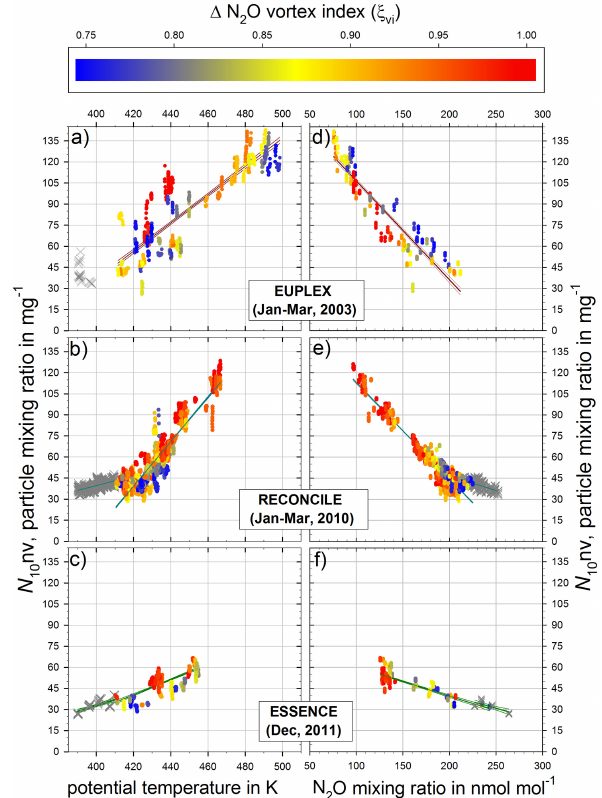
Figure 7. Mixing ratio of non-volatile particles N 10 nv as a function of potential temperature (cid:50) ( a to c ) and as a function of N 2 O mixing ratio ( d to f ) for measurements inside the vortex (i.e., where (cid:49) N 2 O vortex index ξ vi > 0.75). Data points are color-coded by means of (cid:49) N 2 O vortex index in the range 0.75 <ξ vi < 1. Results are sepa- rated for (cid:50) -levels below 410K (crosses) and above 410K (dots) to account for the visible discontinuity (i.e., a transition zone) at the vortex bottom. Linear correlations are assumed for (cid:50) -levels above 410K and linear regressions are implied. These are separately dis- played in Fig. 8 for better